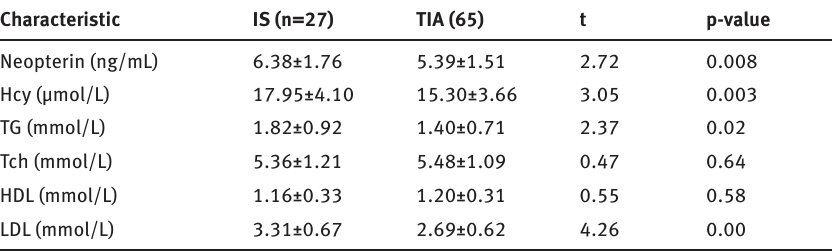
Table 2: Serum neopterin, homocysteine and serum lipid comparison between IS and TIA groups.